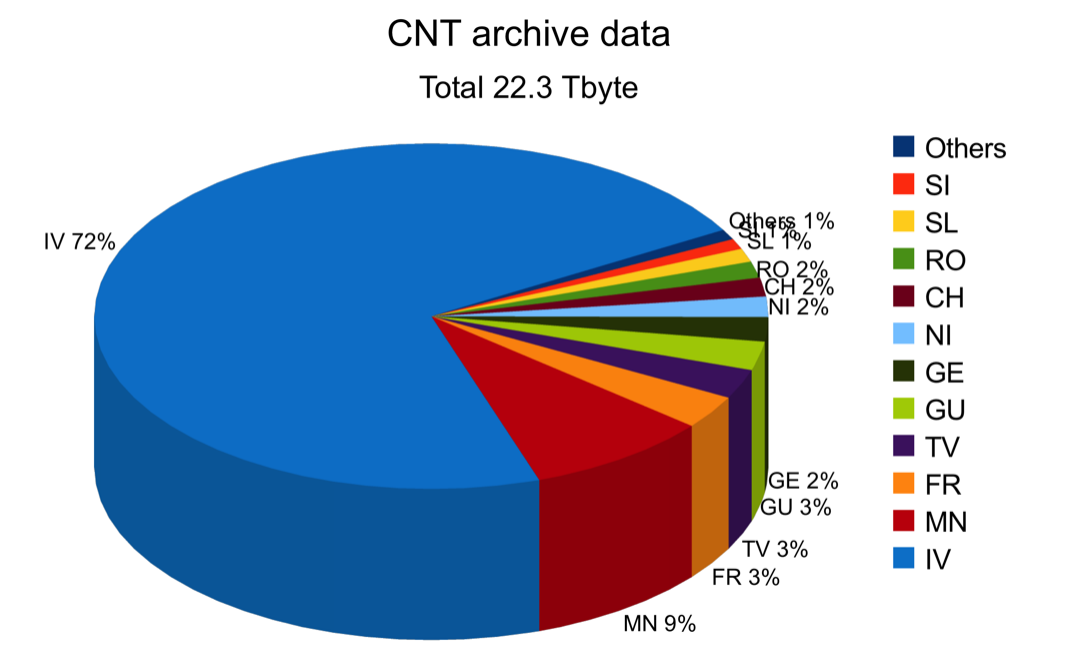
Figure A2. Contributions of other Italian and European seismic networks to the CNT